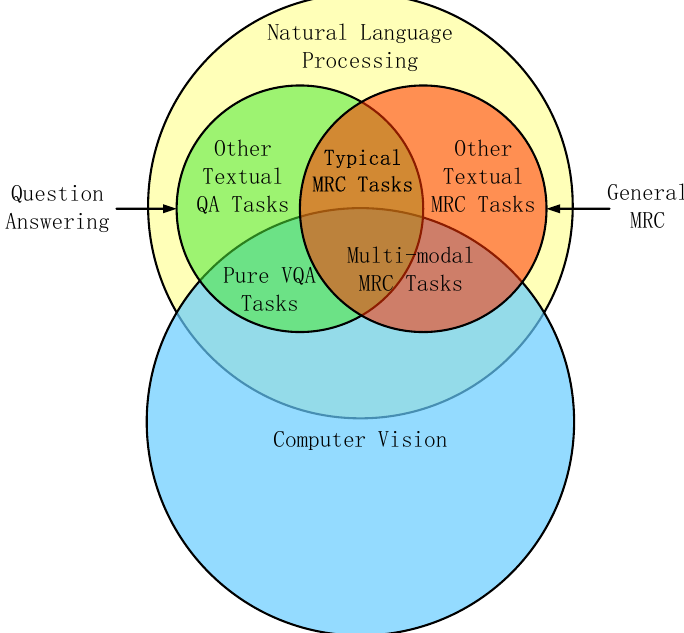
Figure 5. The relations between machine reading comprehension (MRC), question answering (QA), natural language processing (NLP) and computer version